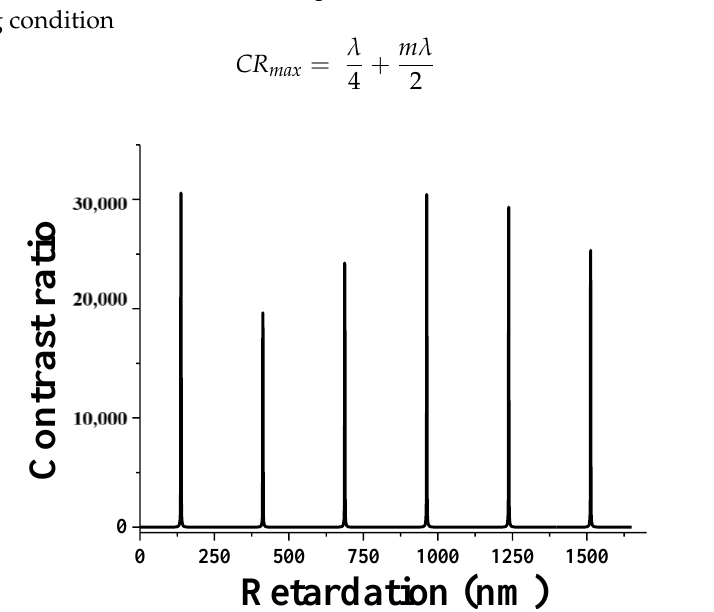
Figure 7. Contrast ratio calculated with respect to the retardation. When the splay state is set to a dark state, a high contrast ratio of about 300,000:1 can be realized.